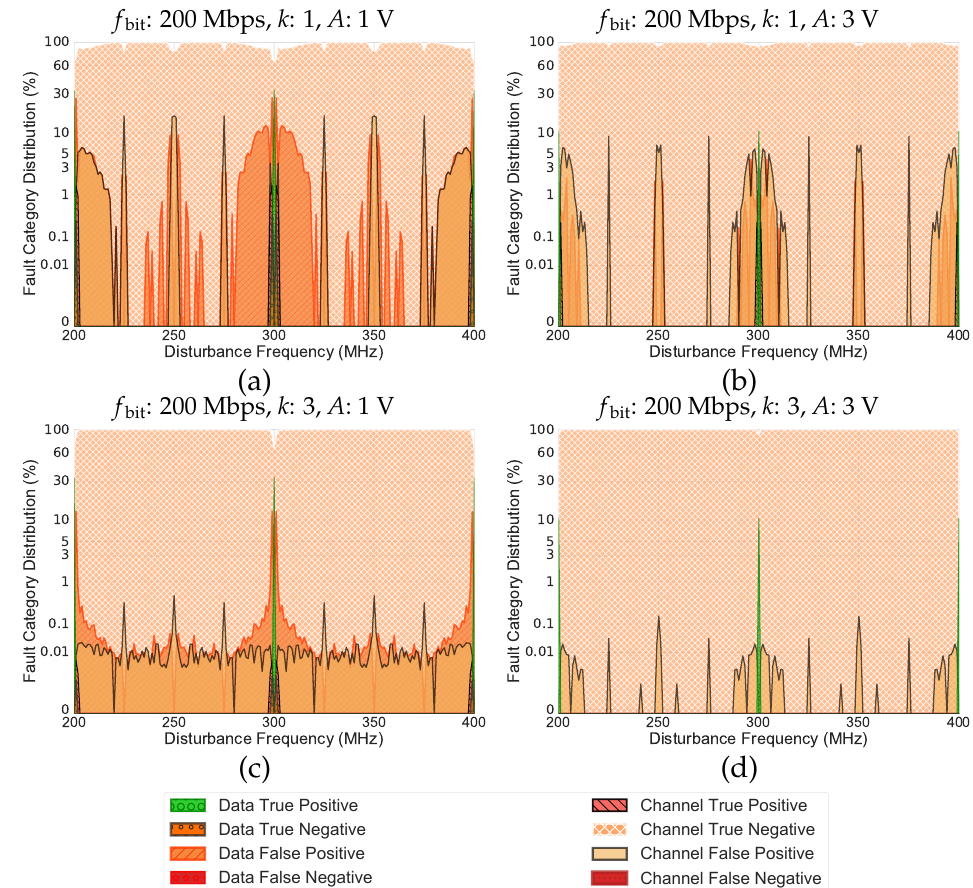
Figure 10. The impact of the inversion layer on the EM-resiliency of RSCodes for a symbol size of